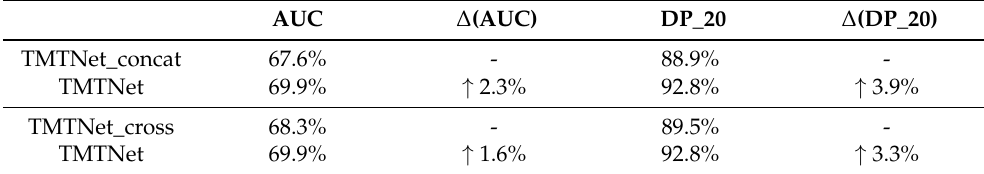
Table 5. The AUC score and DP_20 value of the TMTNet tracker, TMTNet_concat tracker, and TMTNet_cross